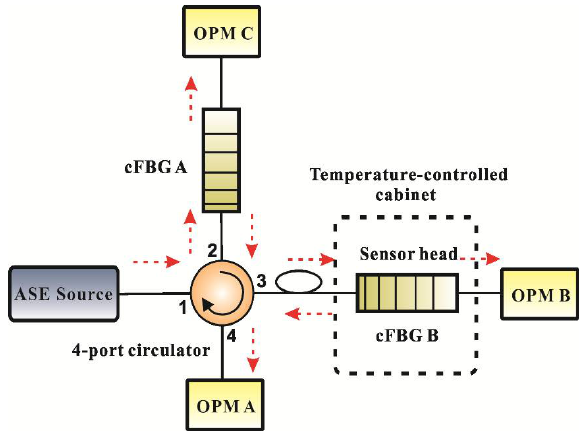
Figure 4. The configuration of a temperature test experiment. See text and Figure 1 for details.